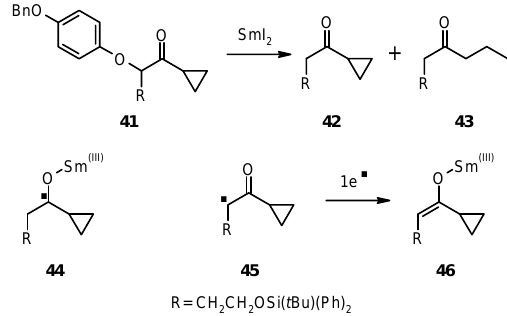
Scheme 12. E xample of SmI